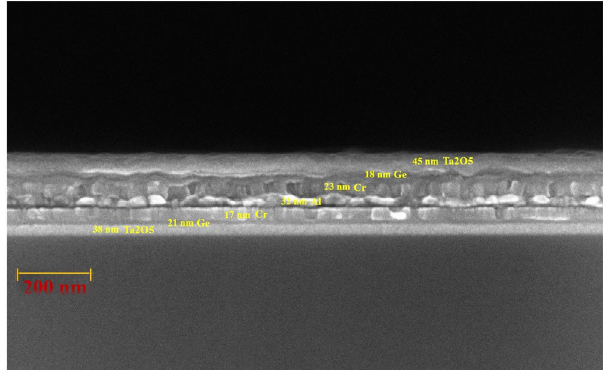
Figure 10. The cross-sectional SEM image of the seven-layered structure.